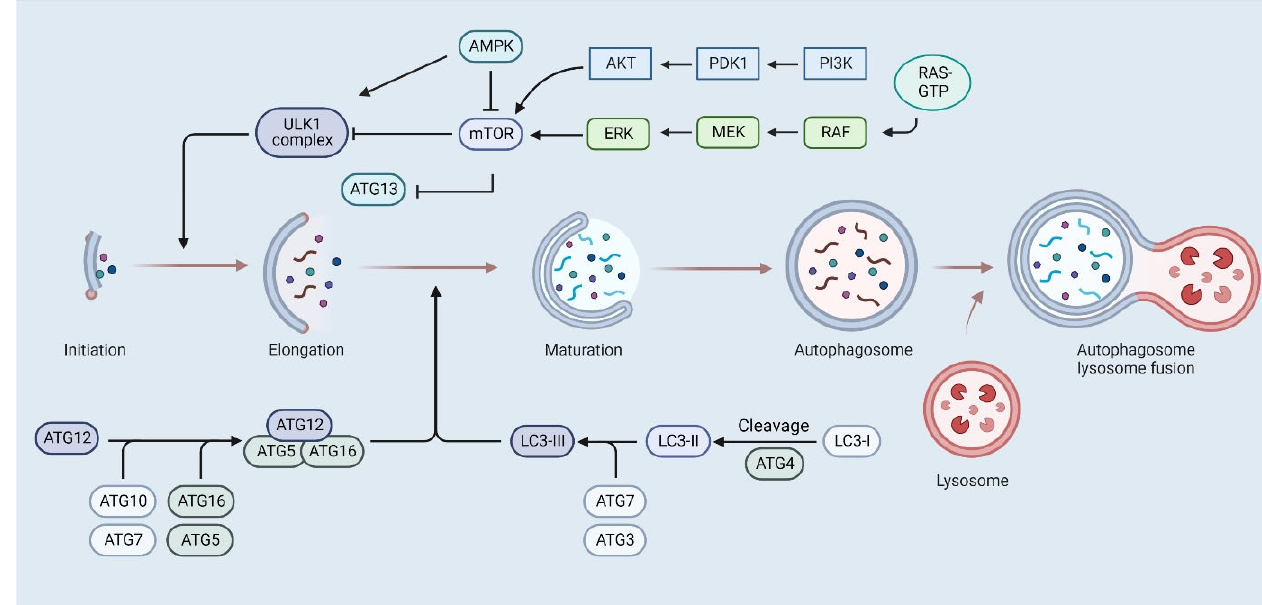
Figure 4. The process of autophagolysosome formation. Stimulated by the mitogen-activated protein kinase (MAPK) and protein kinase B (AKT) pathways, mammalian target of rapamycin (mTOR) and 5’ AMP-activated protein kinase (AMPK) regulate autophagy by interacting with Unc-51 like autophagy activating kinase (ULK1) complex and autophagy-related protein 13. ULK1, activated by AMPK, initiates autophagosome formation from intracellular membranes and its elongation. Then the autophagosome enters the elongation phase. Under the influence of the ATG3, ATG4 and ATG7 proteins, protein light chain (LC3) protein is converted to the LC3-I, LC3-II and LC3-III forms. The autophagy-related proteins (ATGs) (like ATG5, ATG7, ATG10, ATG12, ATG16) together with LC3-III contribute to the maturation of autophagosome that, through fusion with the lysosome, forms an autophagolysosome, which is a structure capable of enzymatic digestion of proteins. Created with